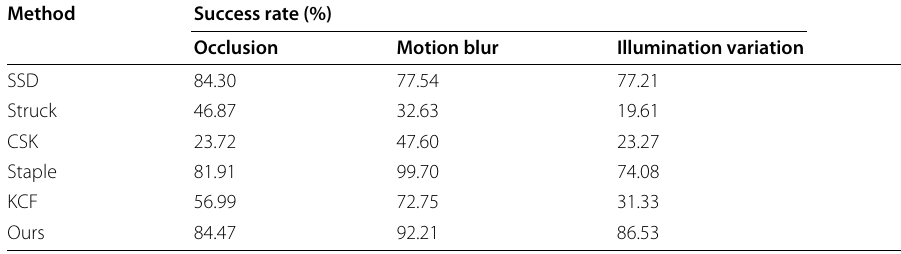
Table 3 Tracking result on videos with sequence